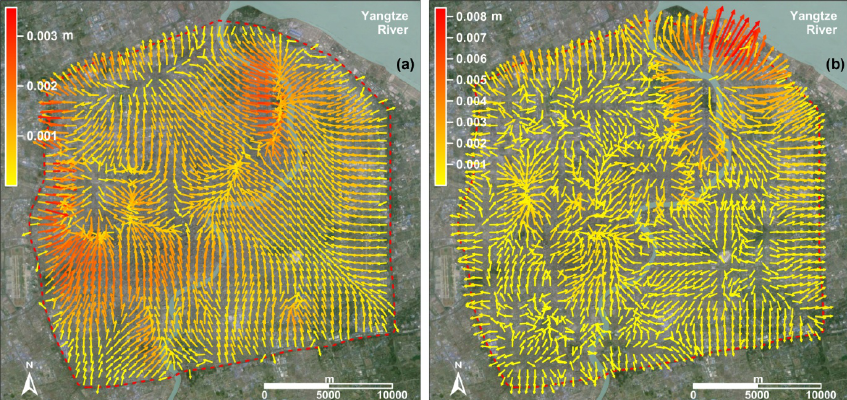
Figure 7. Cumulative horizontal displacements at 30 December 1995, as provided by the 3-D geomechanical model in aquifer A4.